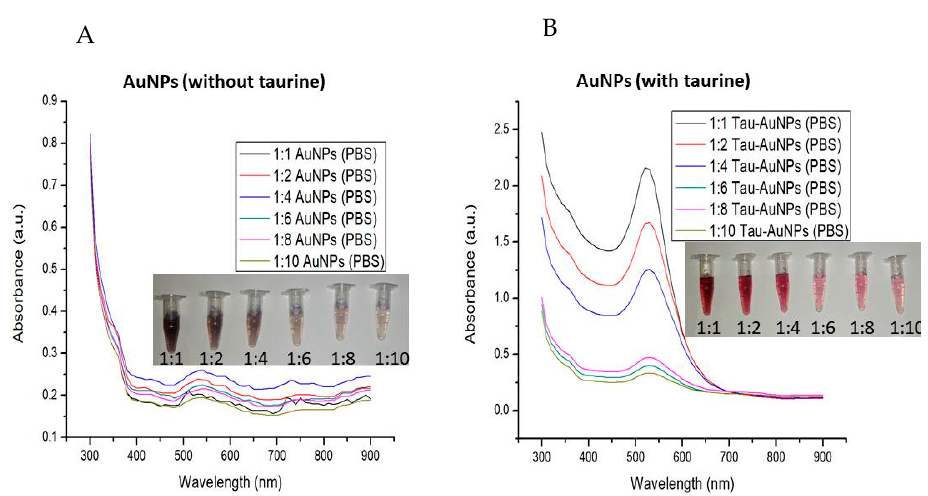
Figure 3. Stability of gold nanoparticles in phosphate buffer saline (PBS): ( A ) Gold nanoparticles synthesized in the absence of taurine showed plasmon peaks that were aggregated, and ( B ) gold nanoparticles synthesized in the presence of taurine showed stable plasmon bands when dispersed in PBS.